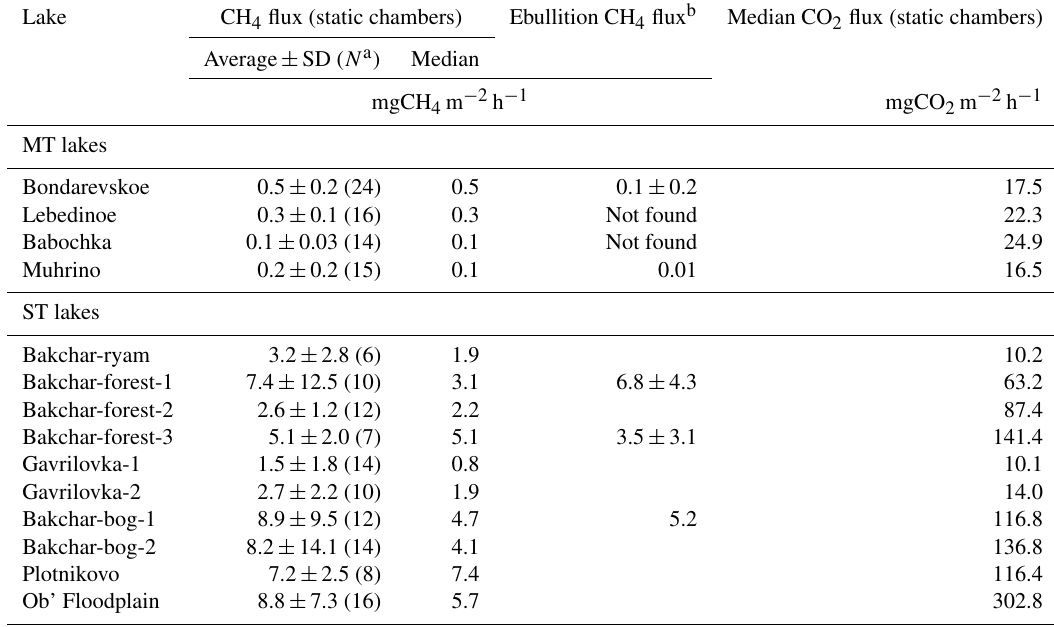
Table 3. Summary of field flux observations (empty cells indicate no